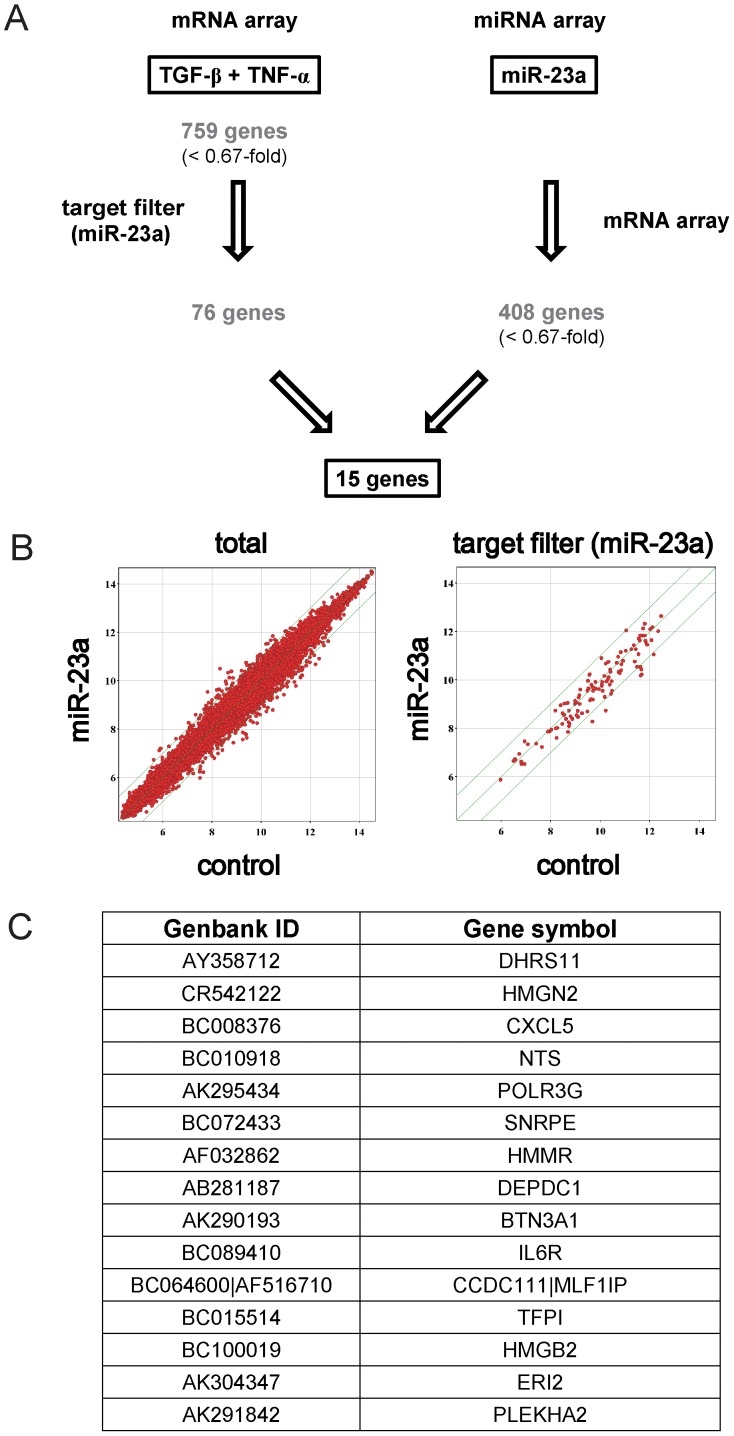
Putative targets of TGF-β-induced miR-23a.(A) Schematic description of integrated analysis of mRNA and miRNA arrays. Gene expression signature in the cells treated with TGF-β1 and TNF-α revealed 759 annotated genes downregulated <0.67-fold. Out of them, the target filter program listed 76 genes as putative miR-23a targets. Transfection of synthetic pre-miR-23a in A549 cells identified 408 genes downregulated <0.67-fold. There were 15 genes shared in these two groups. (B) Scatter plot representation of the transcripts in A549 cells transfected with control (X-axis) or synthetic pre-miR-23a (Y-axis) for 48 h. The transcripts are plotted using log2 normalized data. The threshold of transcript levels was set as induced >2.0-fold or repressed <0.5-fold, and is indicated in each scattergram. Plots of total transcripts (right), and those selected by the target filter program (right), are presented. (C) The list of 15 genes identified by integrated analyses.